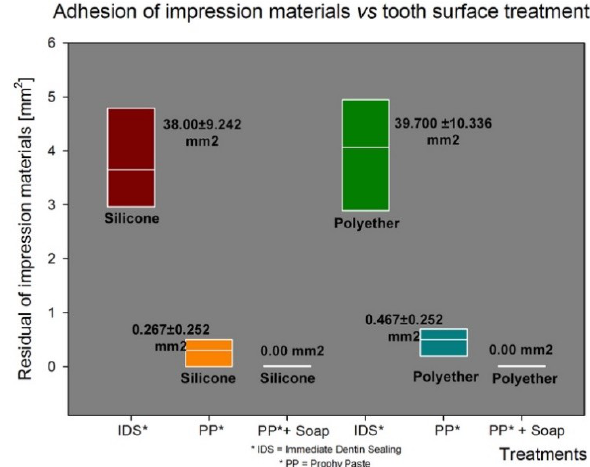
Figure 6. Graphical representation of residual of impression materials on teeth surfaces. The image could help to illustrate the di ff erence between the cleaning protocols, but not between the impression materials used. Table 1. This table shows statistically significant di ff erence between groups ( p < 0.01) using one-way analysis of variance. In the second part, the Holm-Sidak method was performed to verify the significance of the di ff erence between every single subgroup. Only between G2 and G3 are there no statistically significant di ff